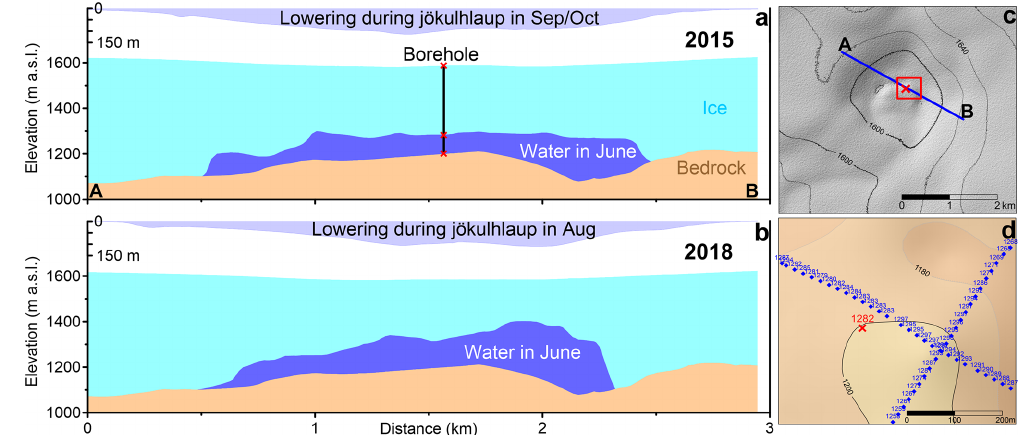
Figure 9. (a–b) Cross section over the centre part of the ESC from location A to B (shown in panel c ) revealing bedrock, lake and ice thickness, 4 and 2 months before the jökulhlaups in 2015 (a) and 2018 (b) , respectively. The lowering along this cross section during the subsequent jökulhlaup (derived from Fig. 7) is shown in the upper part of each panel. Note that the y axis is without vertical exaggeration. (d) Comparison of lake roof elevation measured with RES, 3 June 2015 (blue numbers and diamonds), and through boreholes, 7 June 2015 (red number and x). The borehole location relative to the cross-section A to B is shown in panels (a) and (c) . Red box in panel (c) indicates the area shown in panel (d)